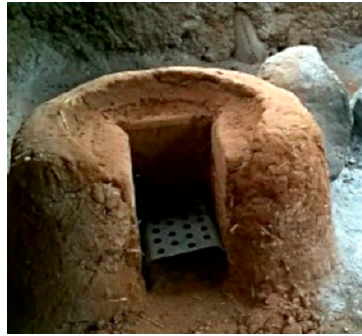
Figure 2. The MA inserted in a horseshoe mud stove.